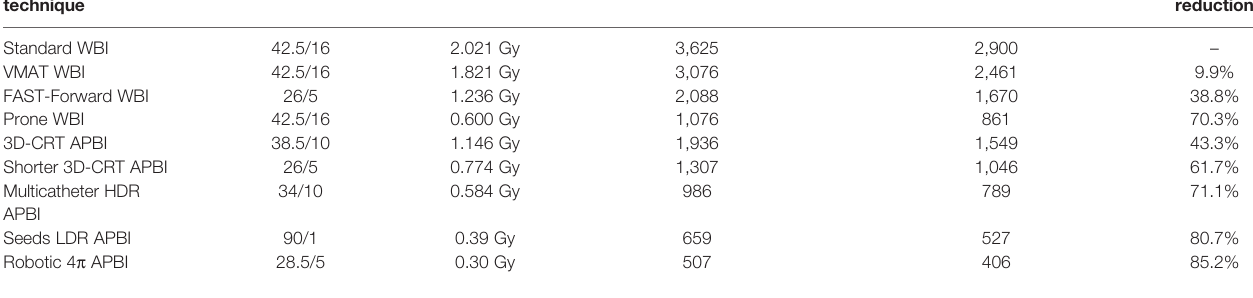
TABLE 4 | Annual number and mortality of secondary lung secondary cancers for patients diagnosed in 2019 with early-stage breast cancers depending on the radiotherapy technique. Radiotherapy technique